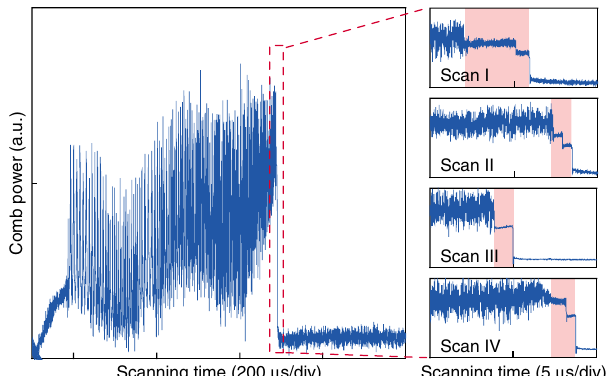
Fig. 5 Observation of soliton formation steps. Experimental traces of the comb power are recorded when the pump laser frequency is scanned from blue to red detuning at a scanning speed of ~10 nm/s. The right panels show the zoom-in traces of four representative soliton formation steps in different scans, of which the number and the amplitude of steps change from scan to